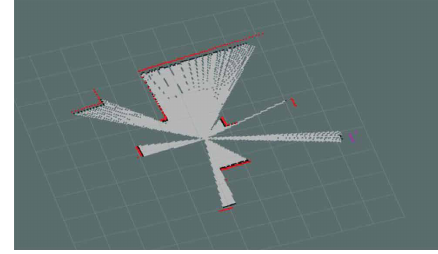
Figure 11: Local environment